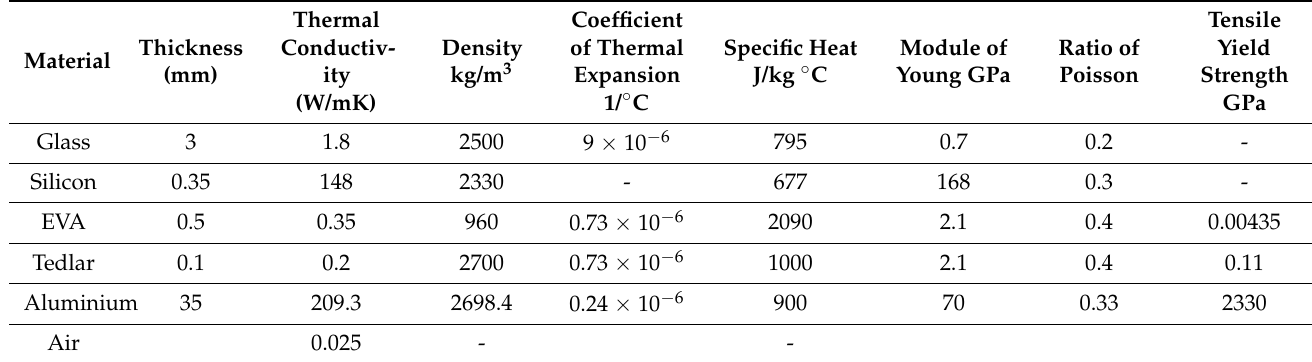
Table 1. Material